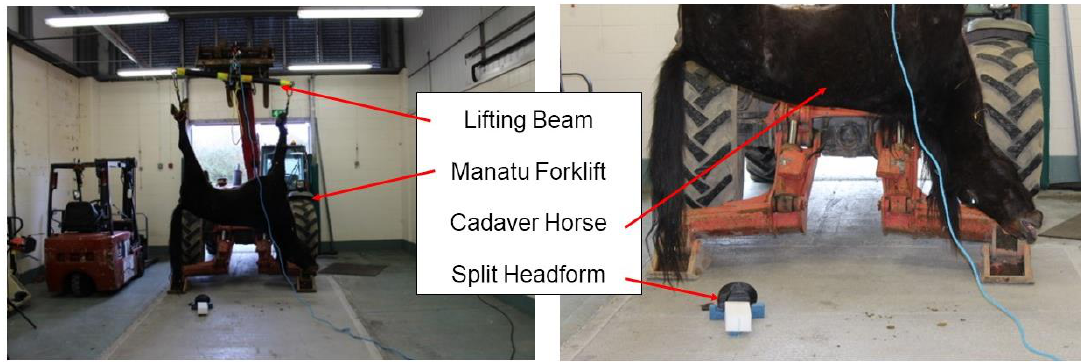
Figure 3. Cadaver horse drop test set up.